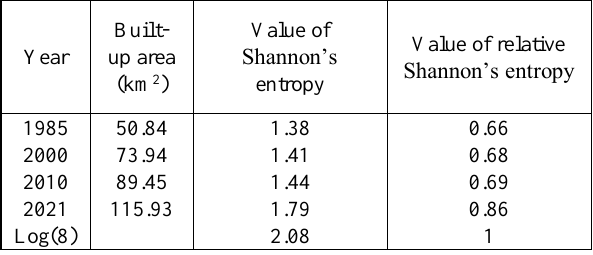
Table 4 . Values of relative and Shannon’s entropy